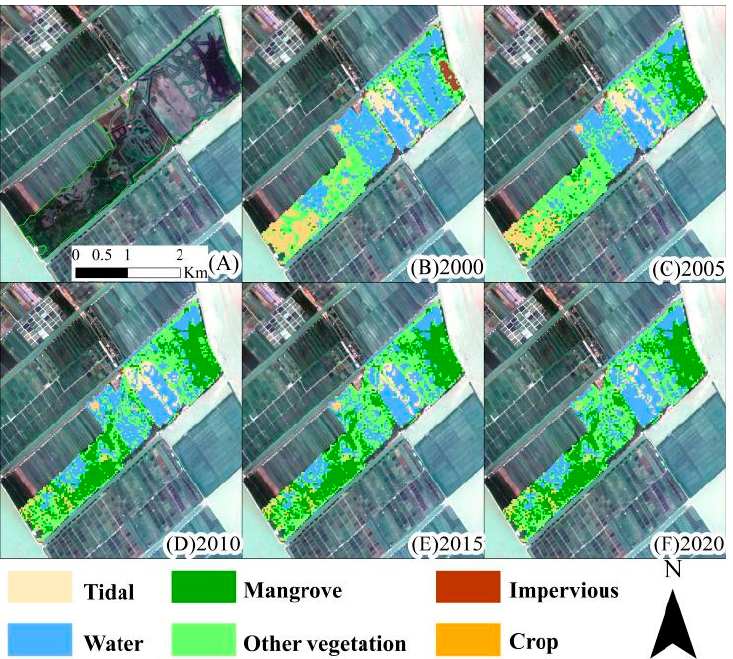
Figure A3. The spatiotemporal changes of mangrove forests in FMNNR from 2000 to 2020. ( A ): the image of FMNNR, ( B ): 2000, ( C ): 2005, ( D ): 2010, ( E ): 2015, ( F ): 2020.